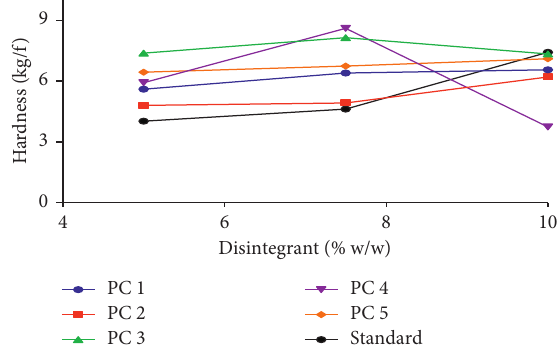
Figure 3: Effect of pectin concentrations as disintegrants on tablet